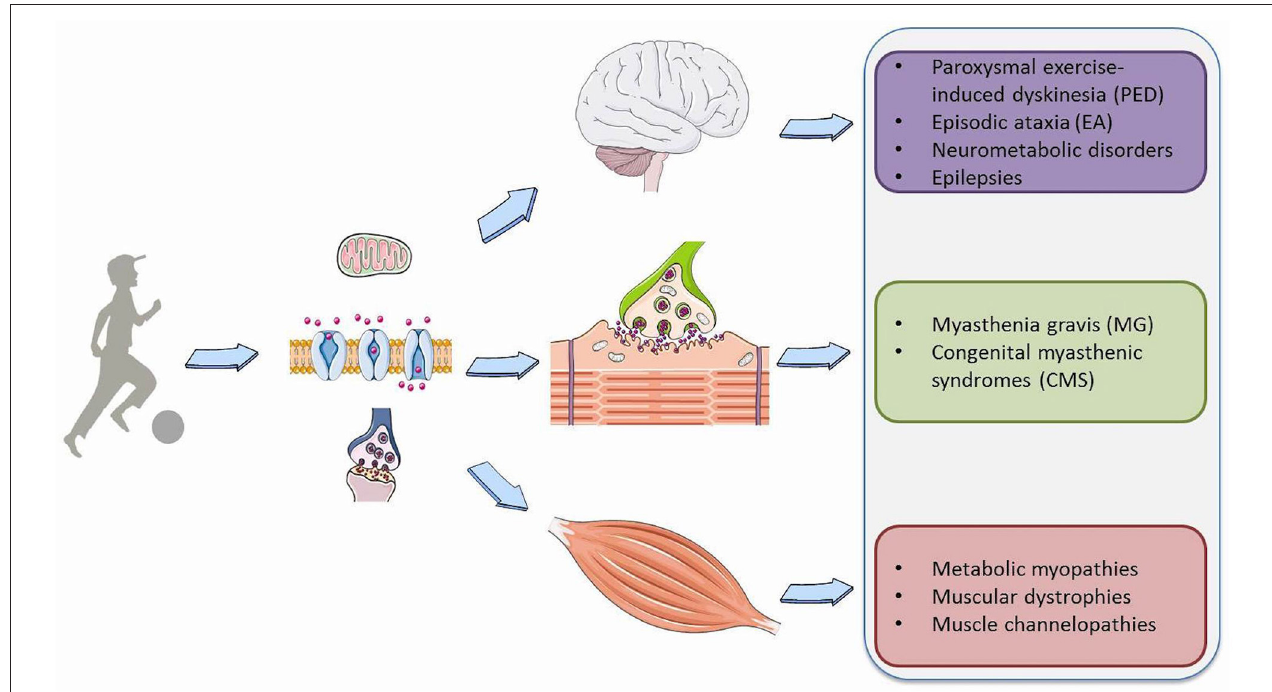
FIGURE 1 | Overview of Paroxysmal exercise-induced neurological